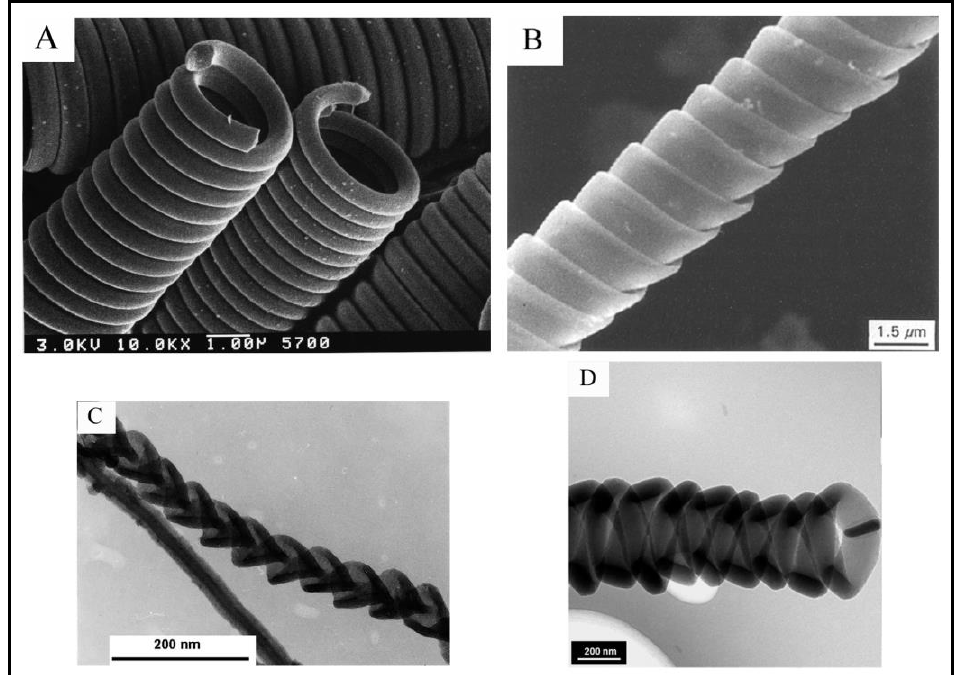
Figure 2. Various morphologies of carbon fibers: ( A ) double-helix regular circular carbon coils ([7], Motojima and Chen, 1999); ( B ) regularly ribbon-like flat coiled carbon fibers ([13], Motojima et al ., 1995); ( C ) nanobraids (together with a carbon nanofiber) ([14], Liu et al ., 2003); and ( D ) intertwined carbon fibers with symmetrical growth mode and centrally located Cu catalyst particle ([15], Shaikjee et al ., 2011).